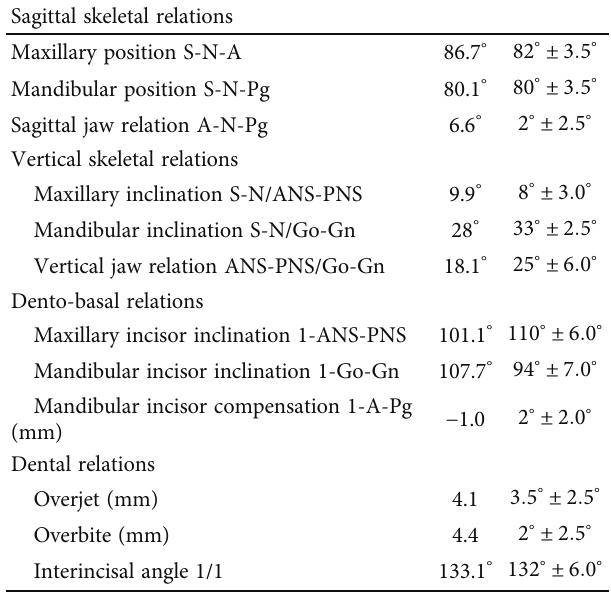
Figure 7: Initial teleradiography. Table 1: Initial Ebo cephalometric values. Table 2: Initial Pancherz cephalometric